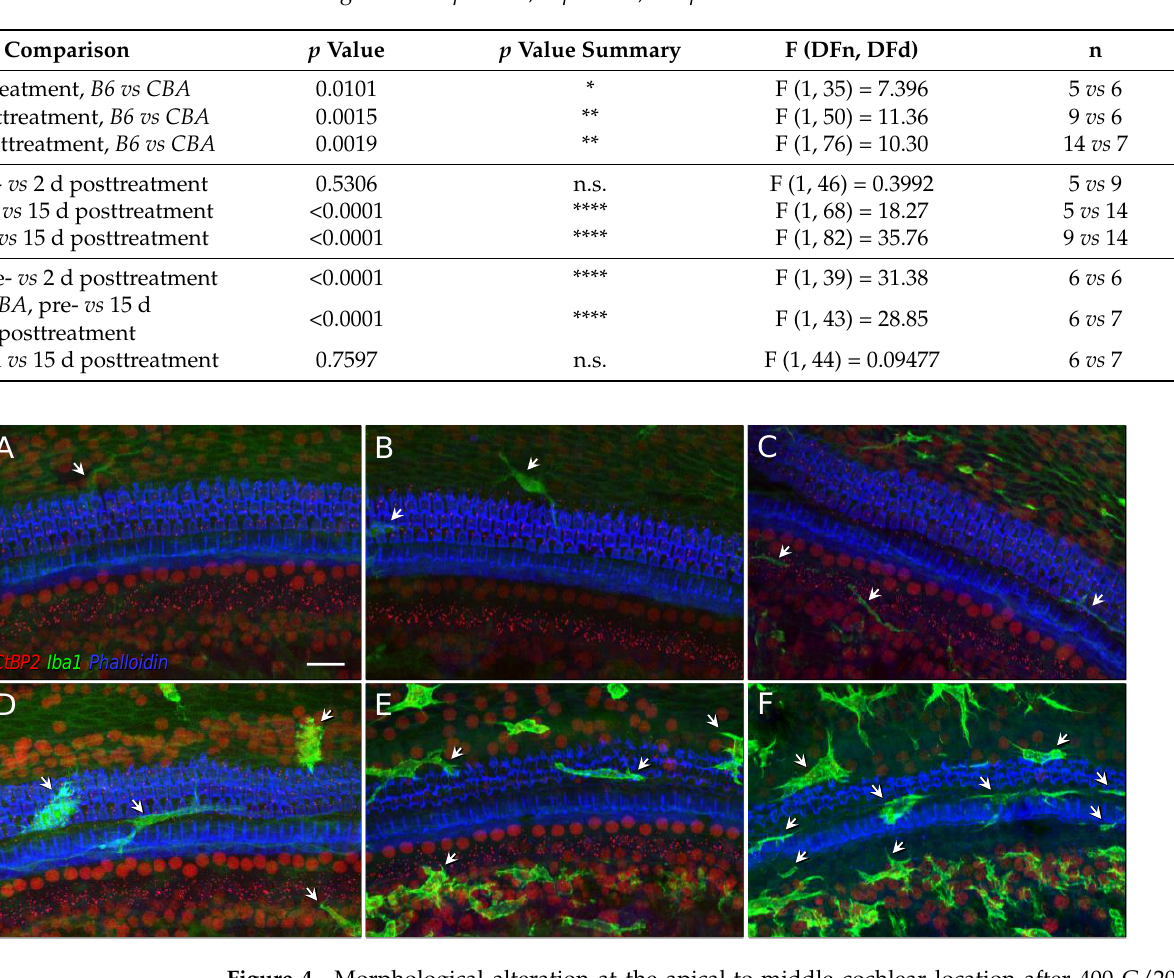
Table 3. Ordinary two-way ANOVA statistics on 400 G/200 F-enhanced BM macrophage density.